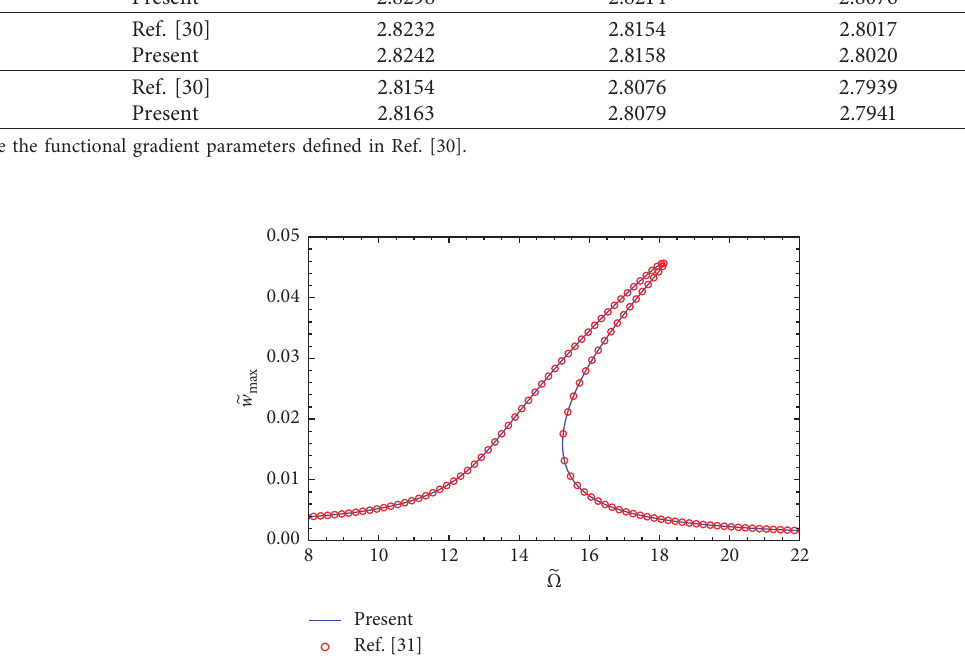
Figure 2: Comparison of the frequency-response of transverse motion of SS BDFG beam with L / h � 12, m